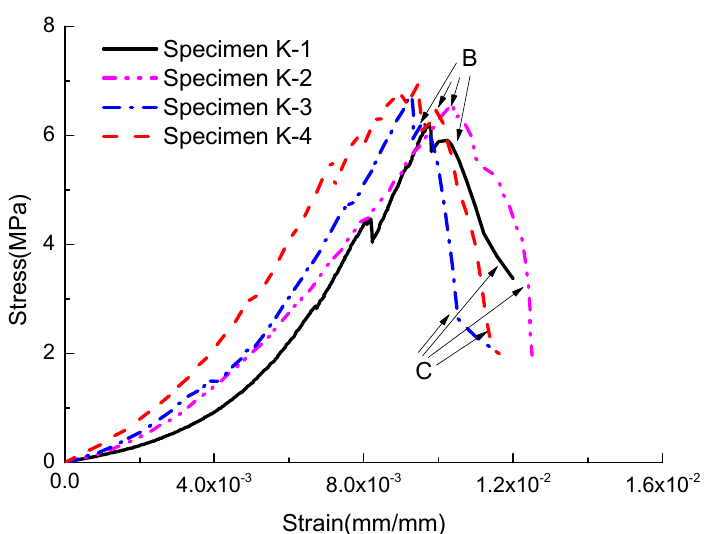
Figure 8. Stress-strain curves of coal specimens under uniaxial compression condition.